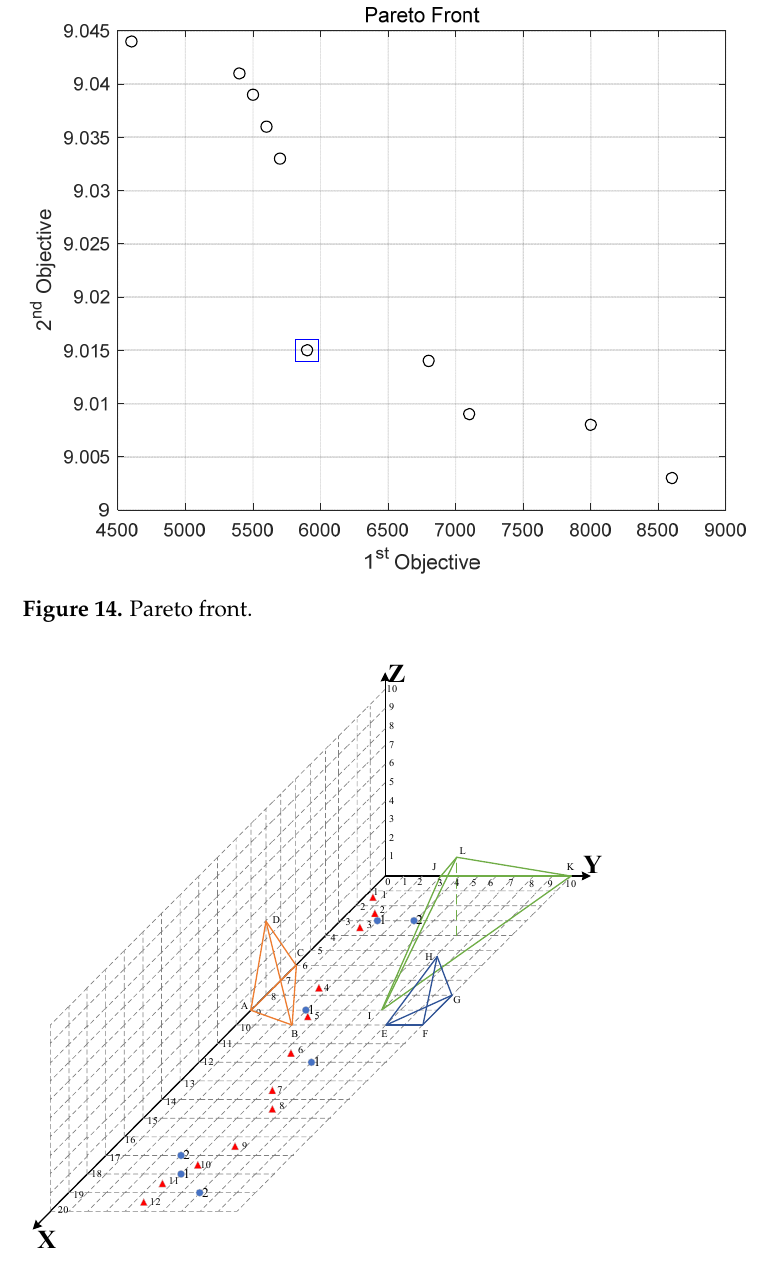
Figure 15. Distribution map of VTS radar station to be built.